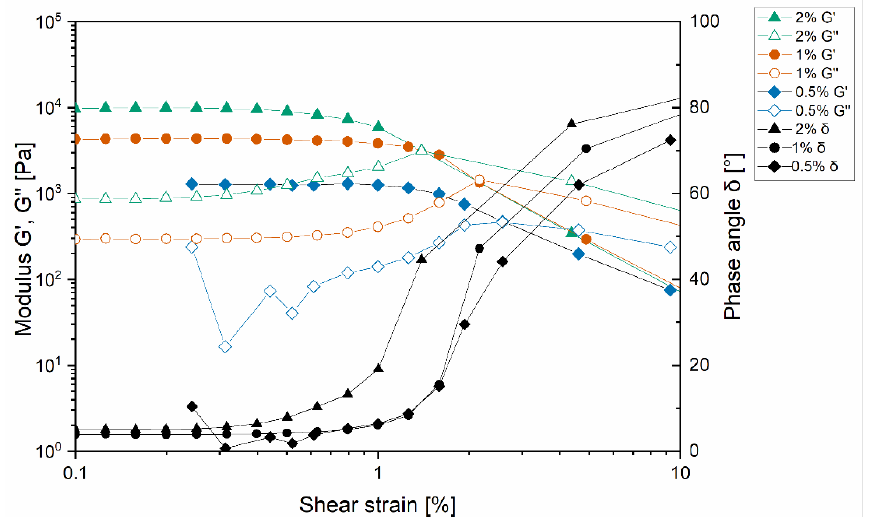
Figure 5. Amplitude sweep measurement for the definition of the linear viscoelastic region of the hydrogels. 0.5% is represented in squares, 1% in circles, and 2% in triangles. Storage modulus, loss modulus, and phase angle are shown for each concentration.